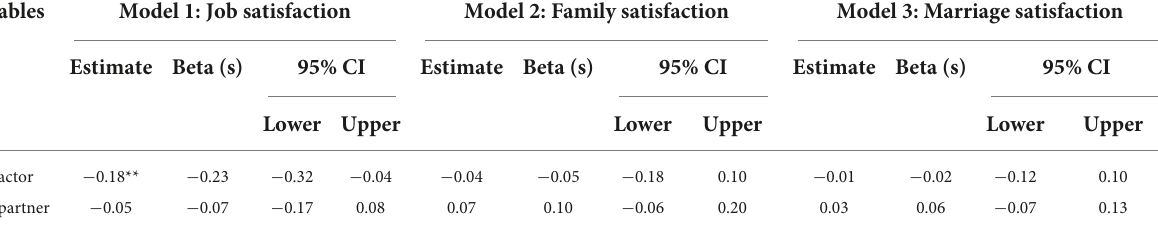
TABLE 2 The APIM results from WIF to dependent variables of stay-at-home spouses. Variables Model 1: Job satisfaction Model 2: Family satisfaction